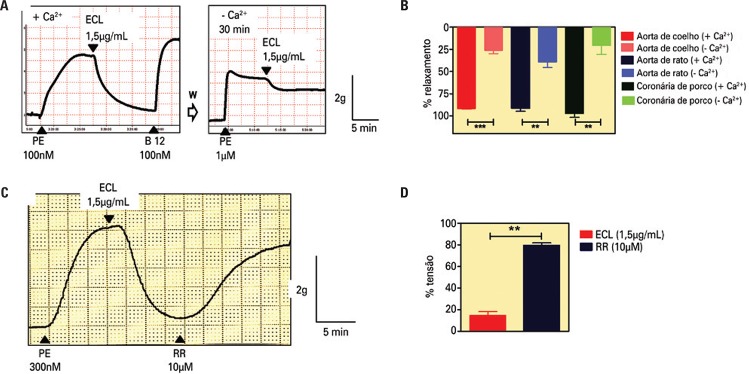
Traçados representativos mostrando o efeito do extrato de Combretum leprosum (ECL; 1,5µg/mL) sobre a tensão isométrica desenvolvida pelos anéis da aorta torácica de coelho pré-contraídos com fenilefrina (PE) (A), na presença (+Ca2+) ou ausência (-Ca2+) de Ca2+ extracelular. Em B, valores médios ± erro padrão da média (EPM) da magnitude do relaxamento (magnitude do relaxamento expresso como porcentagem da redução da contração induzida por PE ou U46619) de quatro experimentos semelhantes em anéis da aorta torácica de coelho e da artéria coronária de porco. Em C, reversão do relaxamento induzido por ECL pelo vermelho de rutênio (RR, 10µM) e, em D, os valores médios ± EPM da tensão de três experimentos semelhantes (tensão expressa como porcentagem da contração induzida por PE). **Teste bicaudal p<0,001 ou ***p<0,0001 (teste t pareado). L: lavagem da preparação por 60 minutos; -Ca2+: lavagem e incubação com solução de Krebs por 30 minutos